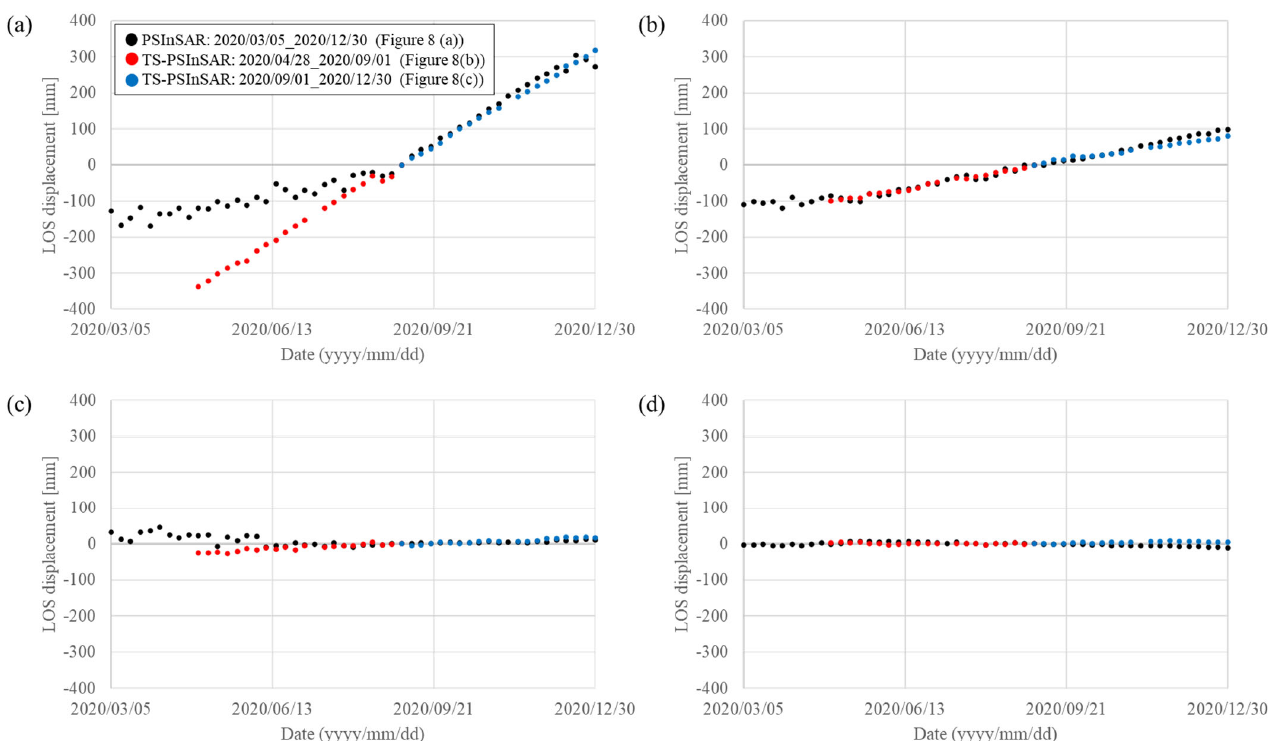
Figure 8. Comparison of PSInSAR result using 10-month data and TS-PSInSAR results using 4-month data: ( a ) mean LOS velocity map using 10-month data from March to December 2020; ( b ) mean LOS velocity map using 4-month data from May to August 2020; ( c ) mean LOS velocity map using 4-month data from September to December 2020. Each point indicated by A, B, C, and D is a point from which LOS displacement time series data were obtained in Figure 9, respectively.